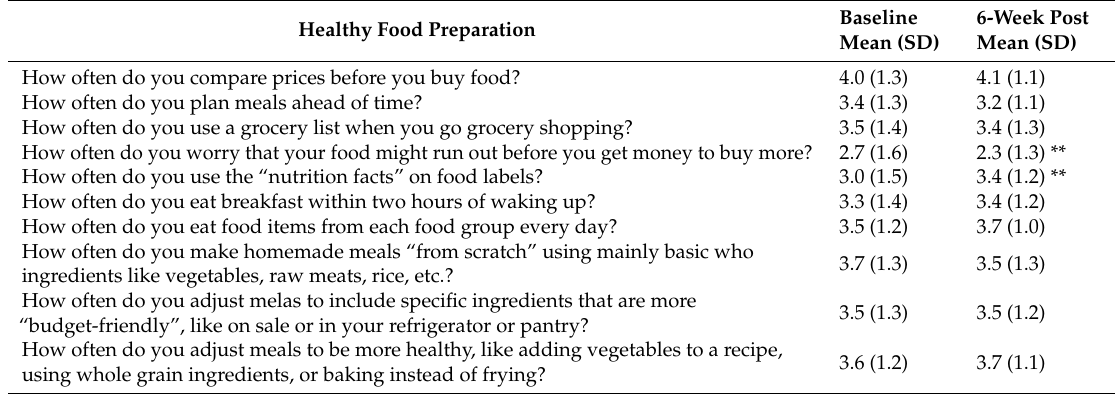
Table 3. Food Management Mean